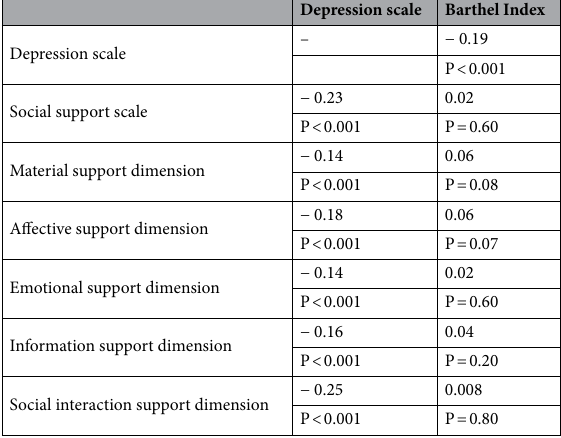
Table 3. Correlation between the depression scale, Barthel Index, and dimensions of social support ( ρ and